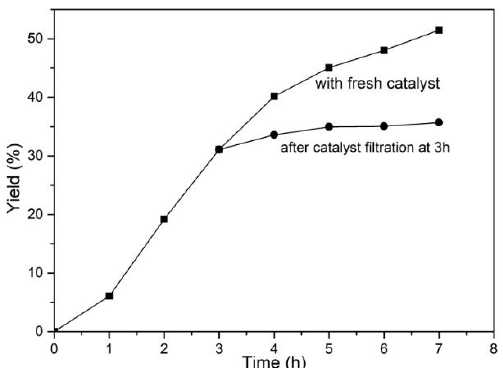
Figure 8. Leaching test in the transesterification of DMC with DEC over fresh ZnCo/NC-600 and after catalyst filtration at 3 h. Reaction conditions: 100 °C, 7 h, 1 wt% catalyst amount.